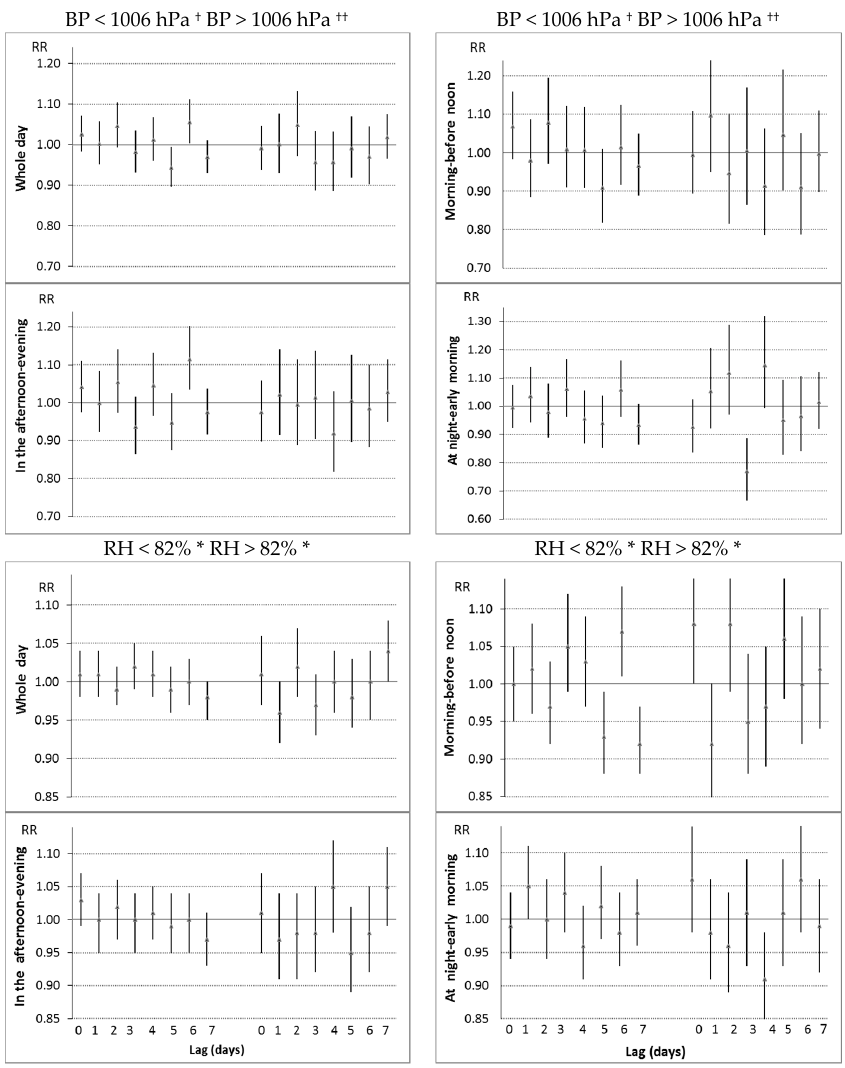
* Rate ratio (RR) per increase in 1 kt for WS and 10% for RH; † RR per decrease in 10hPa; †† RR per increase in 10 hPa. Figure 3. The results of the unconstrained distributed time-lag threshold model for wind speed (WS), barometric pressure (BP), and relative humidity (RH); adjusted for day length, years, the month of the year, the day of the week, and air temperature variables for: the whole day T W (T W = max(T − 1, 0)) with a lag of 0–1 days and a decrease in daily T W during the period of 3–5 days before the call; in the morning until before noon, with T W with lags of 0–1 and 5–7 days, respectively; in the afternoon until the evening, with T W with a lag of 0–1 days; and at night until the early morning, with T W on the day of the call.